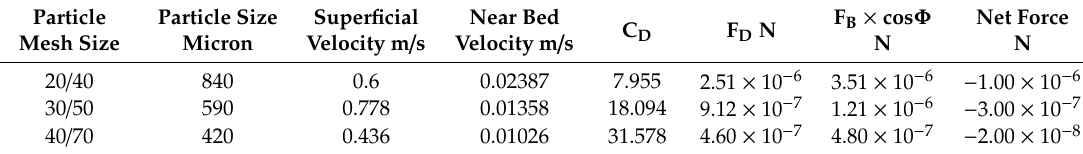
Table 5. Forces acting on a single untreated sand particle at sub-critical velocity.